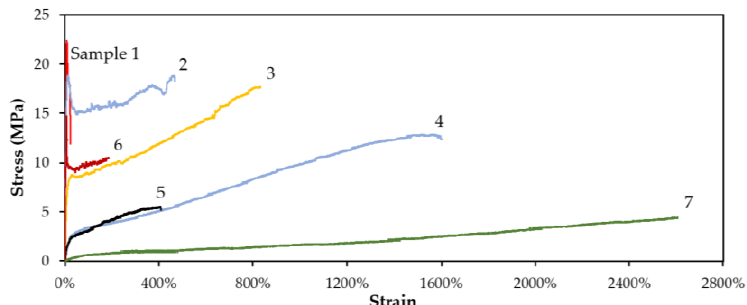
Figure 7. Polymer solvent cast films with increasing 3M2MP units. ( a ) Sample 1 (5.5 mol% 3M2MP); ( b ) Sample 2 (10.1 mol%); ( c ) Sample 3 (34.2 mol%); ( d ) Sample 4 (53.9 mol%); ( e ) Sample 5 (54.8 mol%); ( f ) Sample 7 (100 mol%).